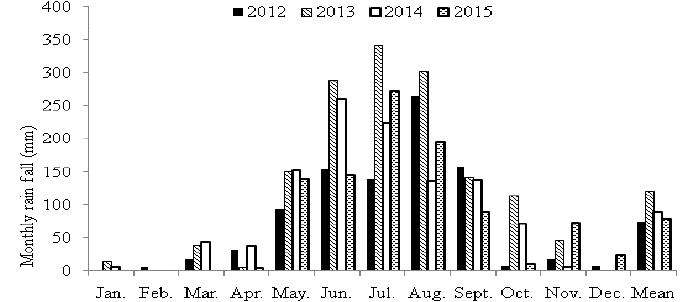
Figure 1. Mean monthly rainfall at of the Bako Agricultural Research Center, Ethiopia, 2012–2015.